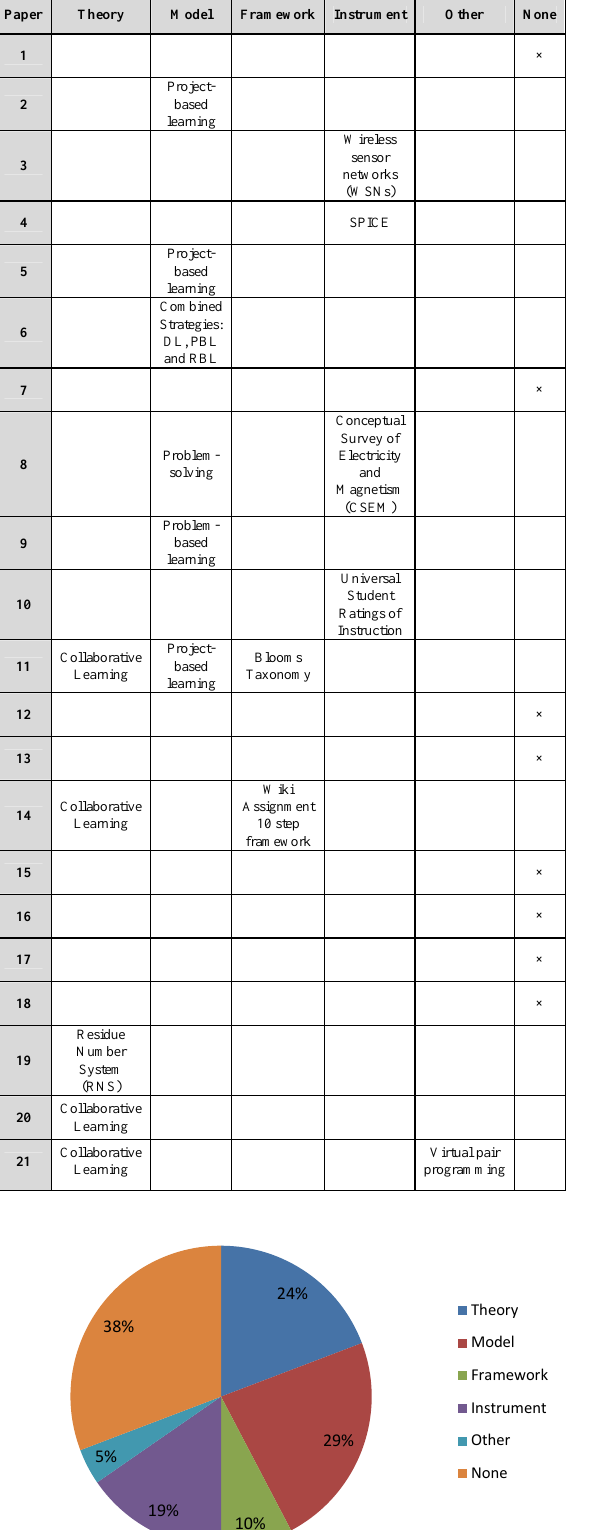
TABLE I. TMFI D IMENSION , IEEE T RANSACTIONS V OL . 54, N. 1